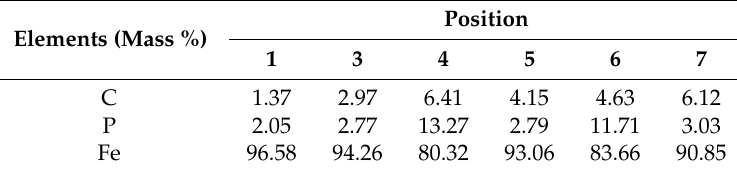
Table 4. Results of EDS analysis for metal